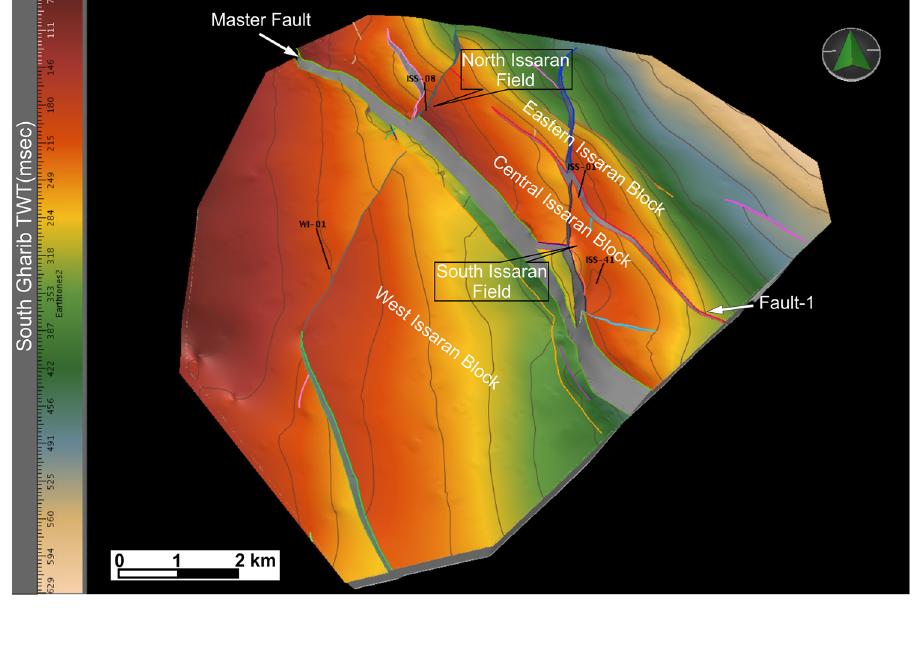
Fig. 13 Instantaneous phase time slice at 252 ms reveals a sharp change in the response between the main Issaran three blocks, with a significant change towards the extreme eastern part of the Gulf of Suez. Notice the fault terminations are identified